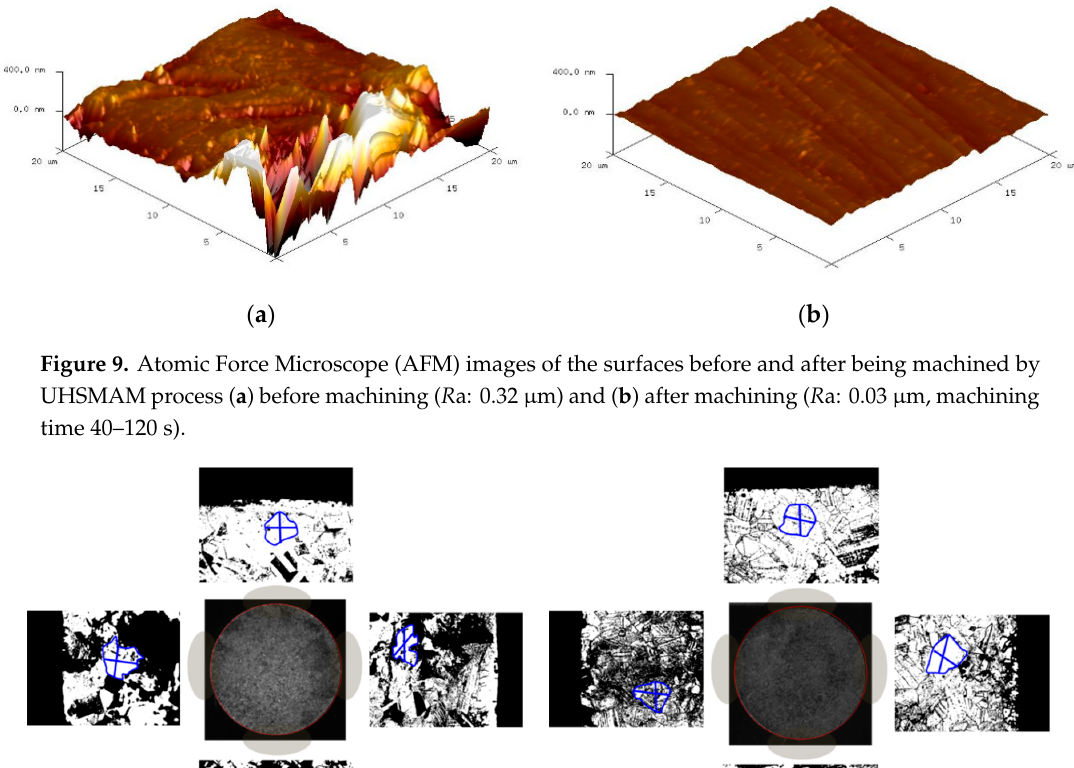
Figure 10. Recrystallized microstructures showing plastic deformation zone with recrystallization at